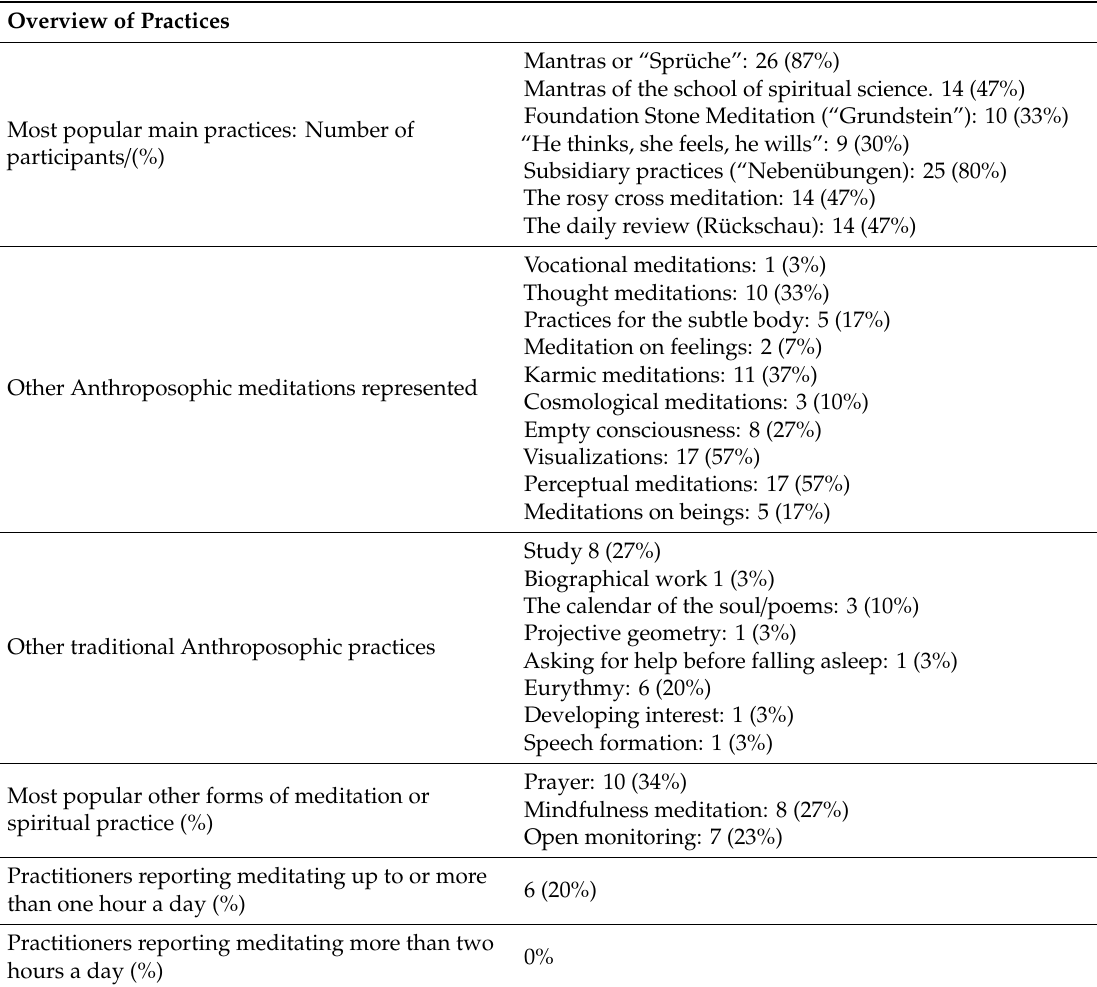
Table 2. Overview of Practices. Numbers indicate prevalence in the present sample (N = 30). Overview of